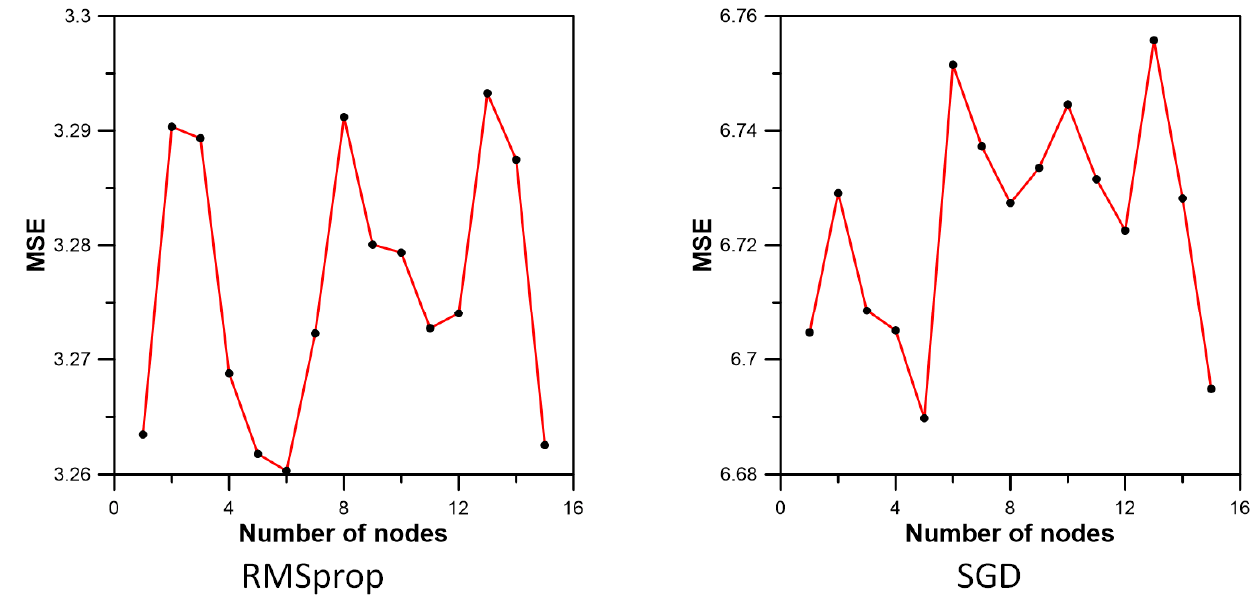
Figure 18. Results according to the number of hidden layers (RMSprop and SGD).